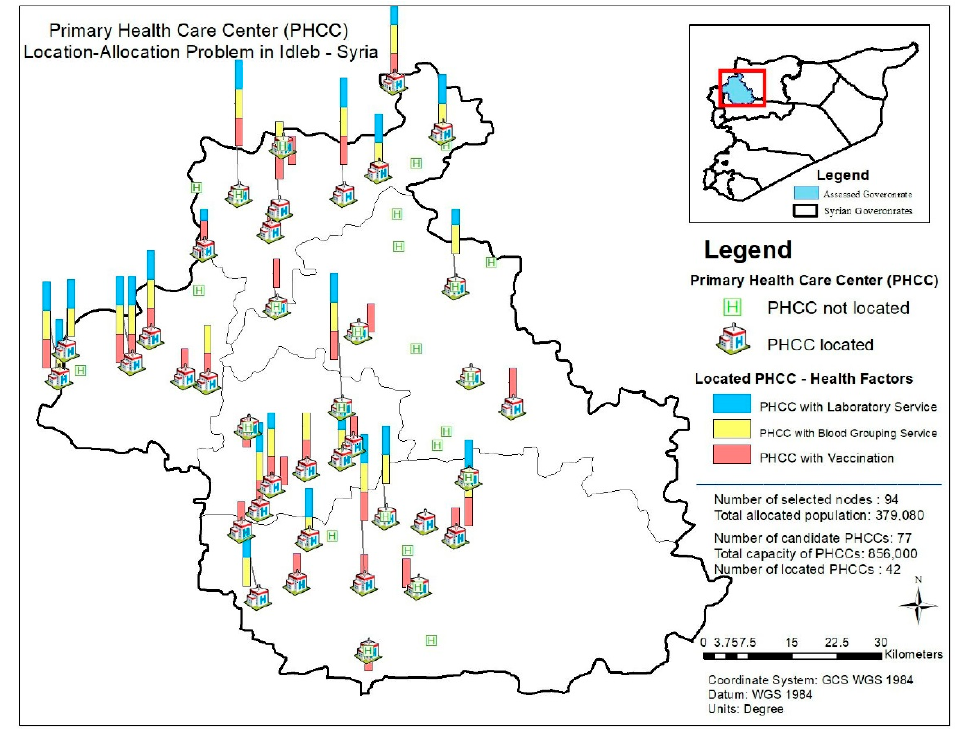
Figure 7. Availability of health factors for the located PHCCs.